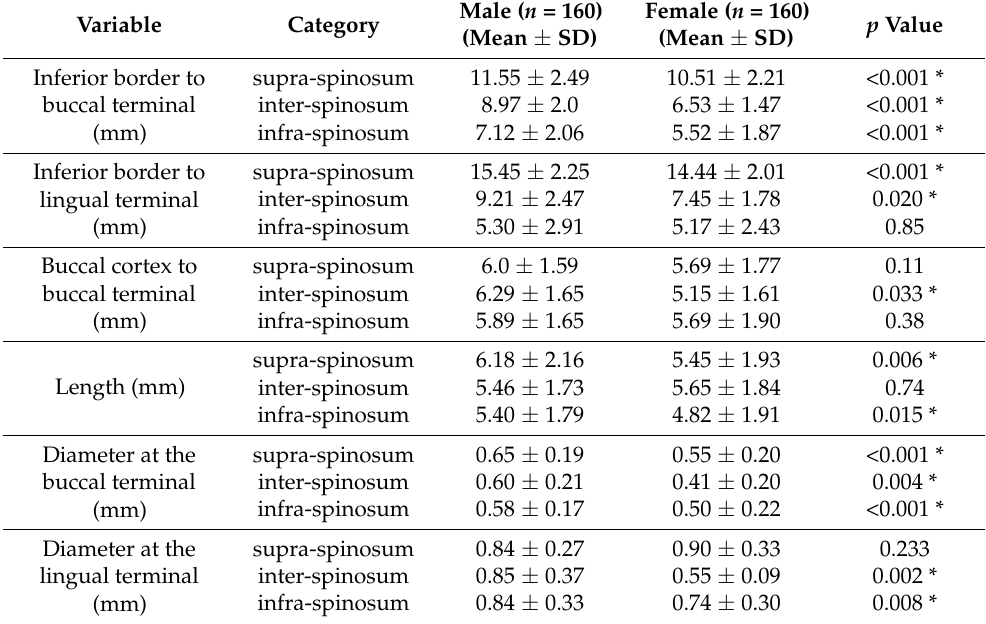
Table 4. Comparison between males and females according to study variables measurements ( n =